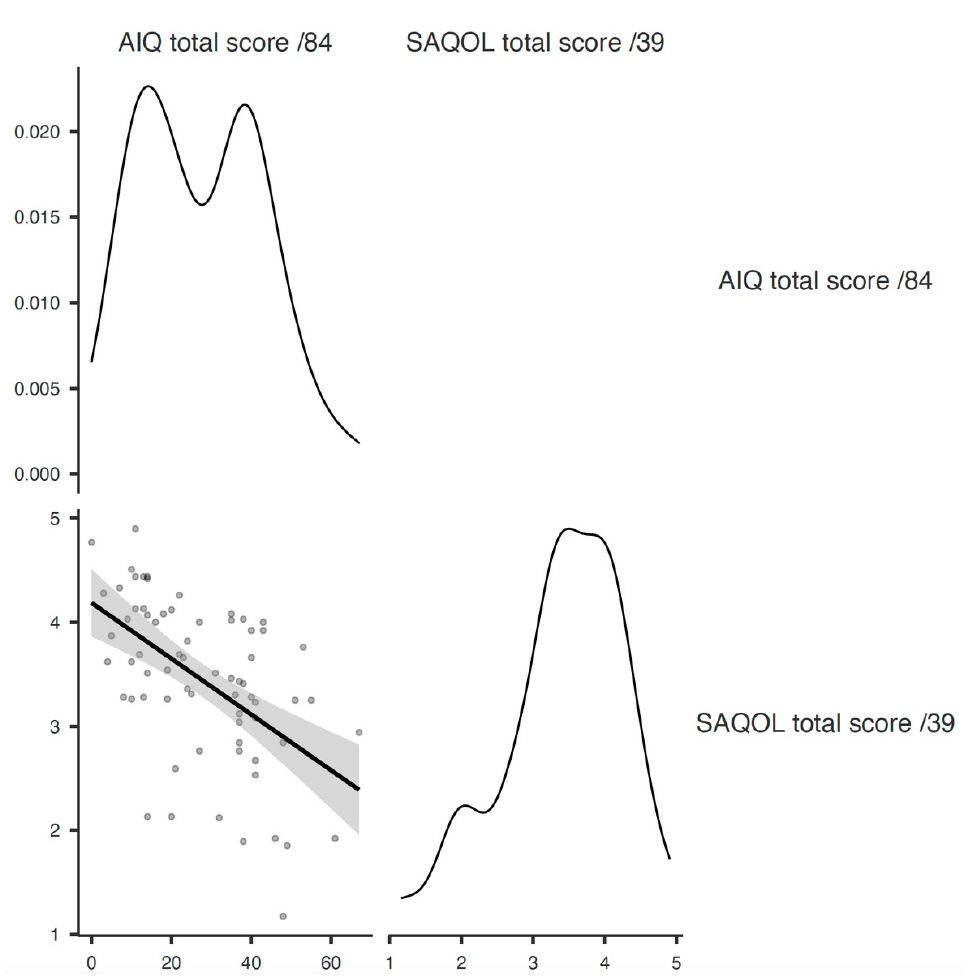
Emotional state/Well-being − 0.516 *** Note: *** p < 0.001.